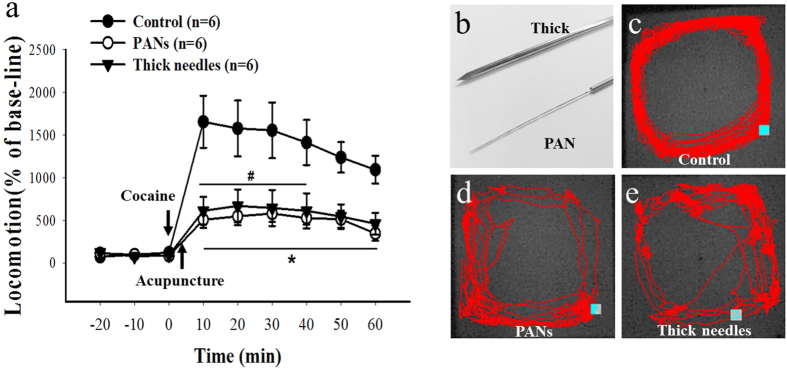
(a) Comparison of PANs and thick (1.6 mm diameter) smooth surface acupuncture needles on attenuation of cocaine induced hyper-locomotion (15 mg/kg, i.p.) by HT7 acupuncture. (*p < 0.05 stands for the difference between control and PANs; #p < 0.05 stands for differences between thick acupuncture needle and control. Blue squares in (c–e) indicates the start position of the rat).